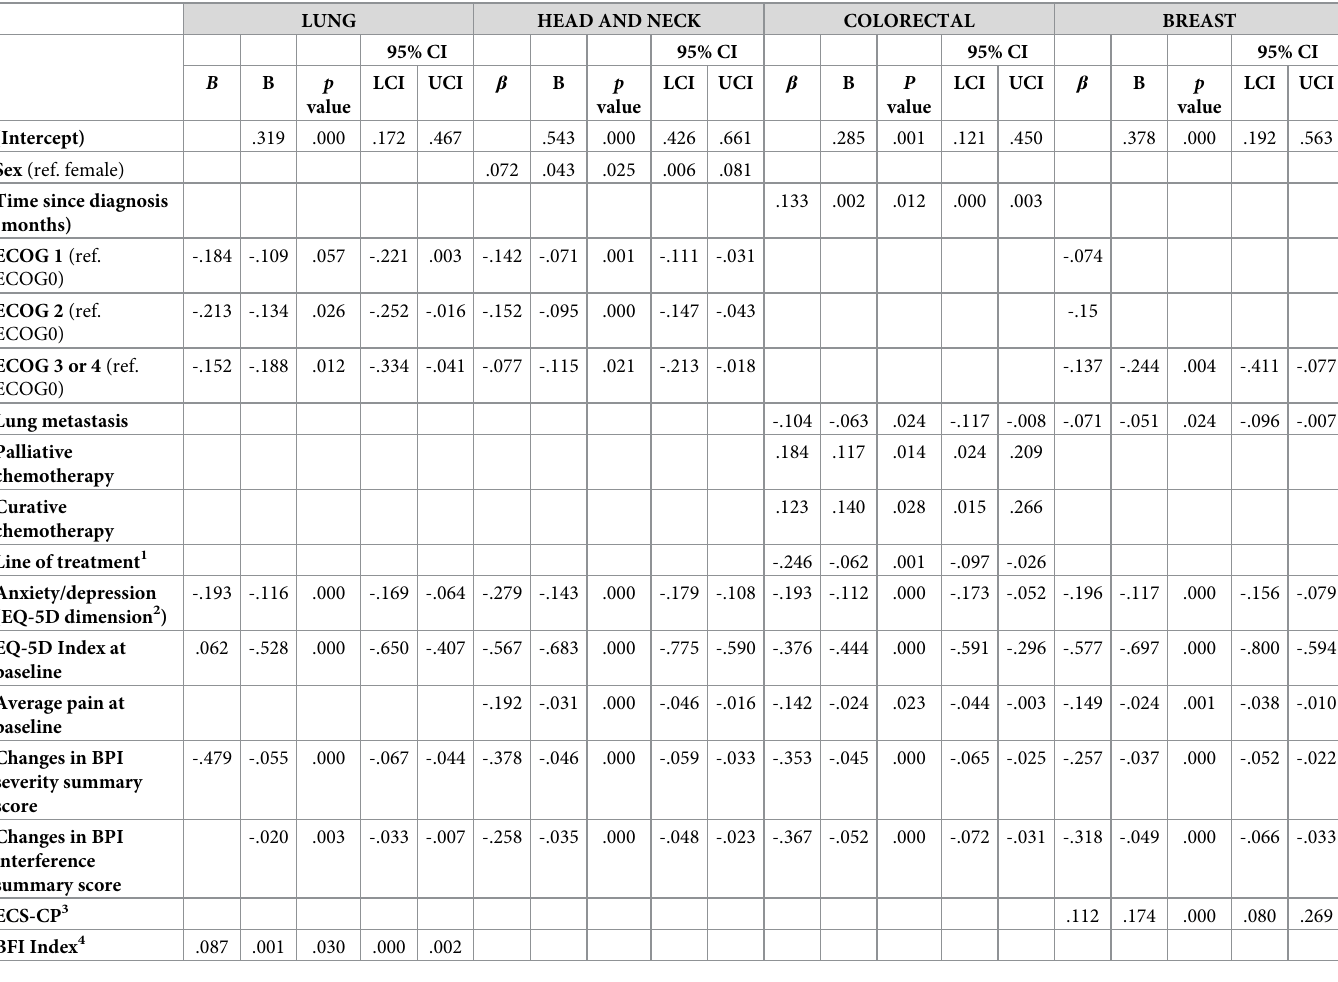
Table 4. Factors predicting change in QoL measured by the EQ-5D Index: Multivariate regression analyses.